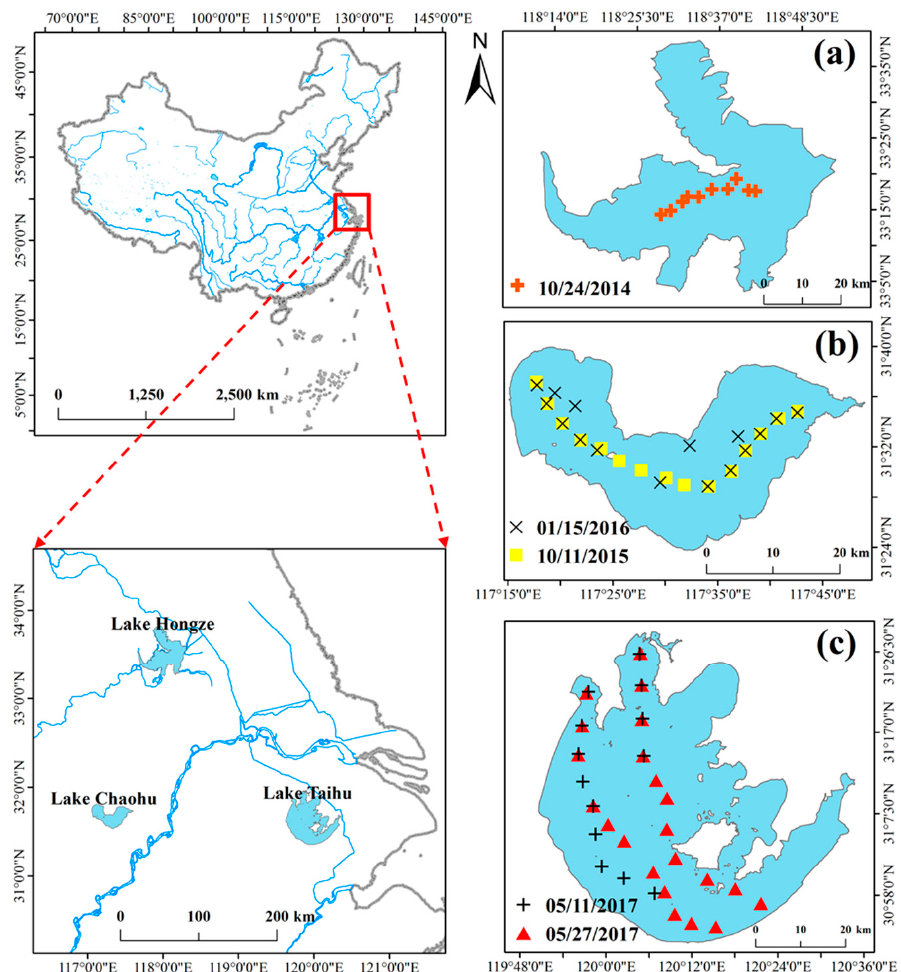
Figure 1. Study lakes and in situ sampling points. ( a ) Lake Hongze, ( b ) Lake Chaohu, and ( c ) Lake Taihu. Dots, triangles, crosses, and forks represent the in situ sampling locations.